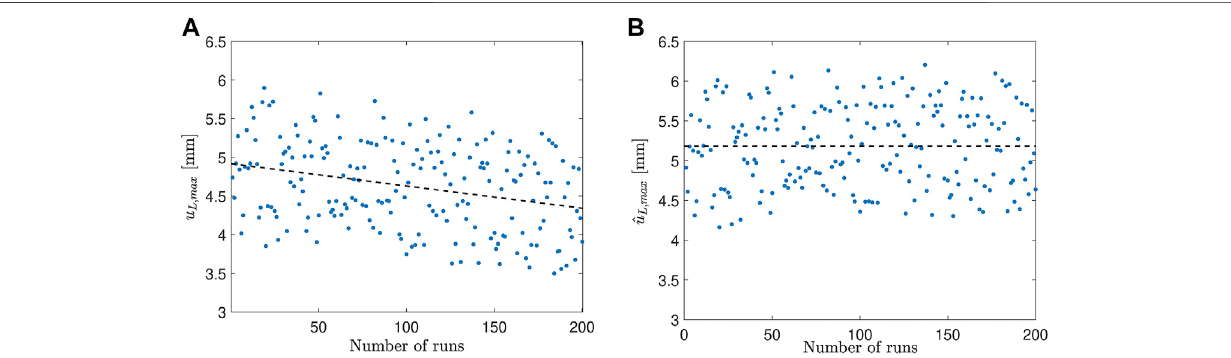
FIGURE 7 | Effect of detrending on the QoI: (A) original values ( u L , max ) and (B) values after detrending ( ^ u L , max ). Dashed lines indicate a linear trend of data.